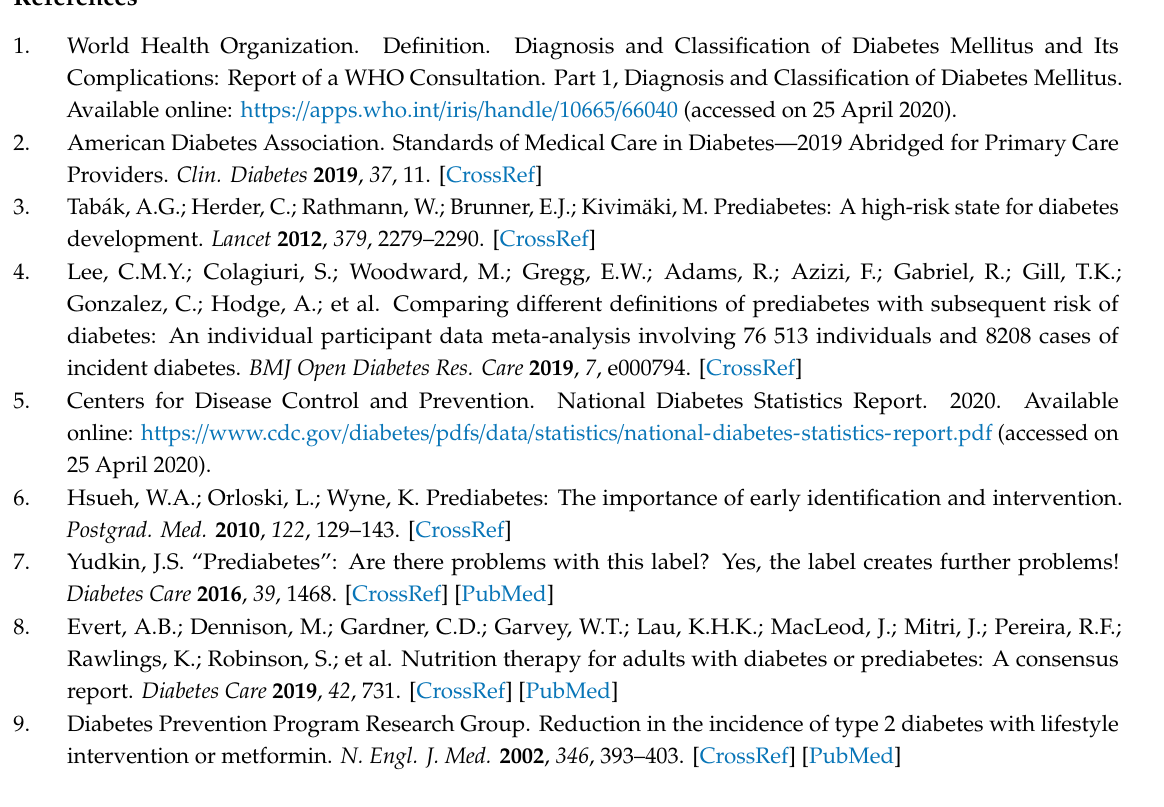
Table S1: Search strategy employed for Ovid MEDLINE, Table S2: Exclusion criteria for this scoping review, Table S3: Summary of included studies (n = 95), Table S4: Intervention focus of included studies, Table S5: Outcomes of included